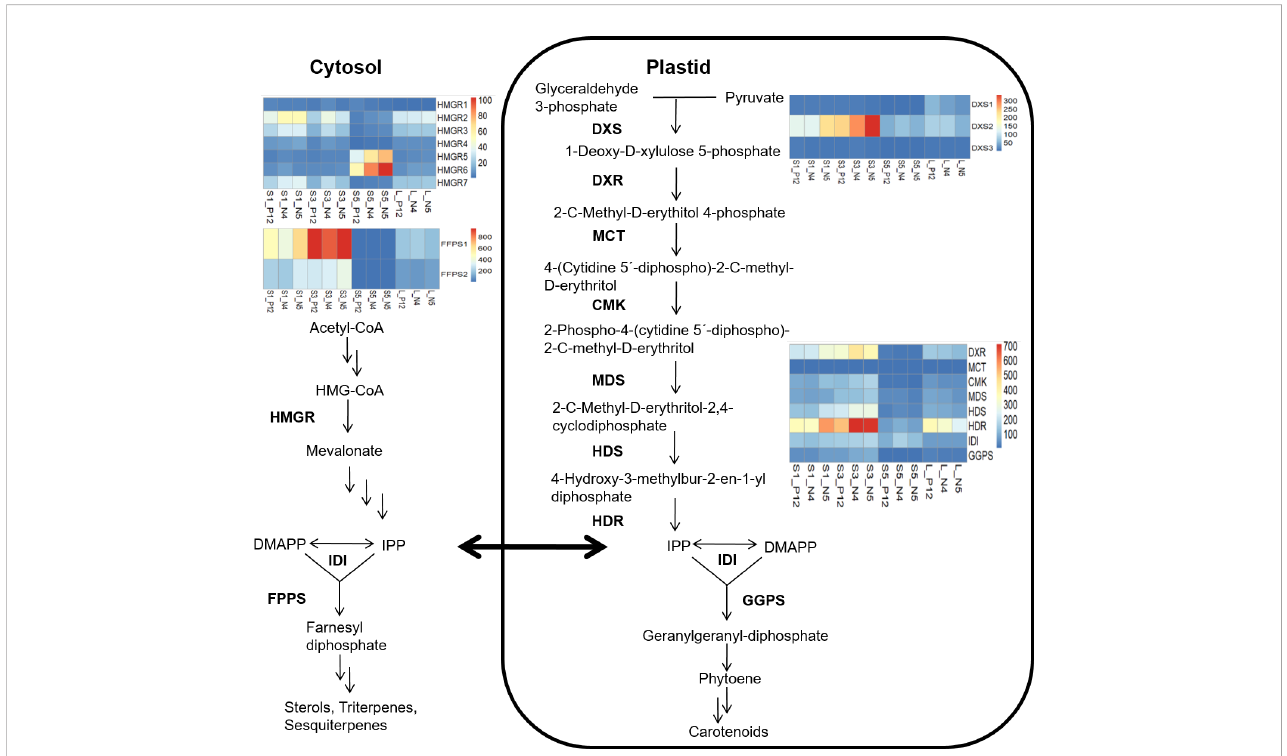
FIGURE 4 MAV and MEP pathways supply the biosynthesis of terpene and carotene molecules during seed development in different B . orellana accessions. Mature leaves of each accession were also analyzed to show the gene activation in the biosynthesis of photosynthetic molecules. Genes with well-known functions of regulatory checkpoints in the MAV and MEP pathways are showed. Heat maps show the TPM values of each gene. Bo nomenclature from gene names was removed to simplify the images.